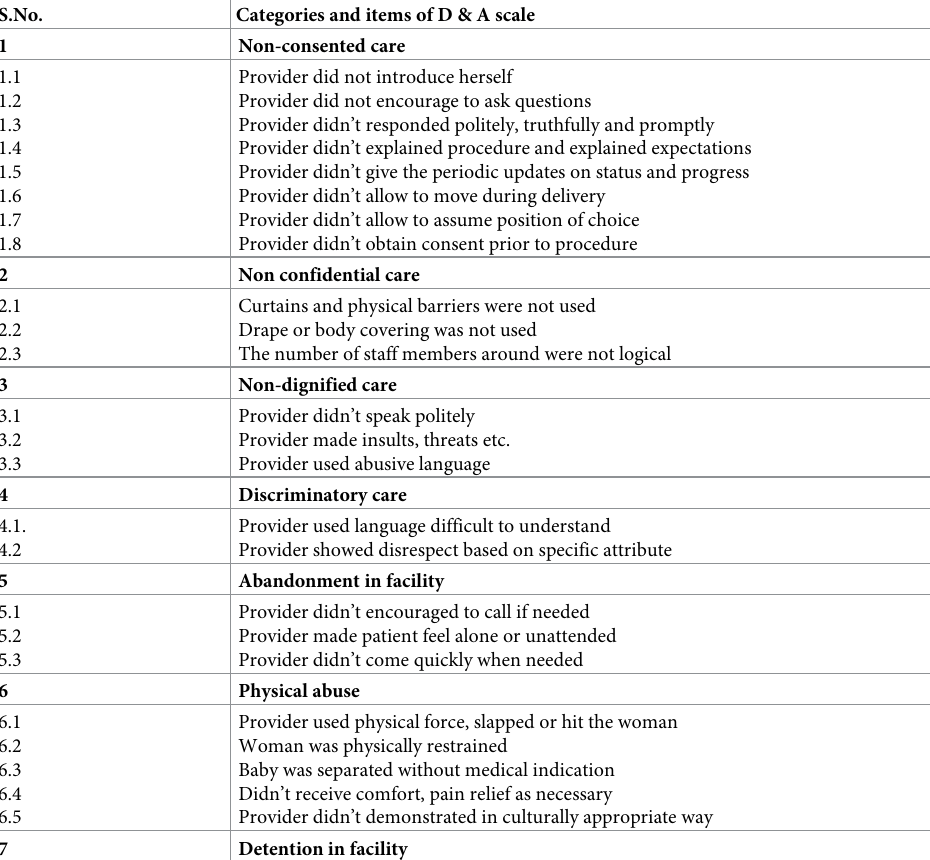
Table 1. Categories of disrespect and abuse during childbirth.